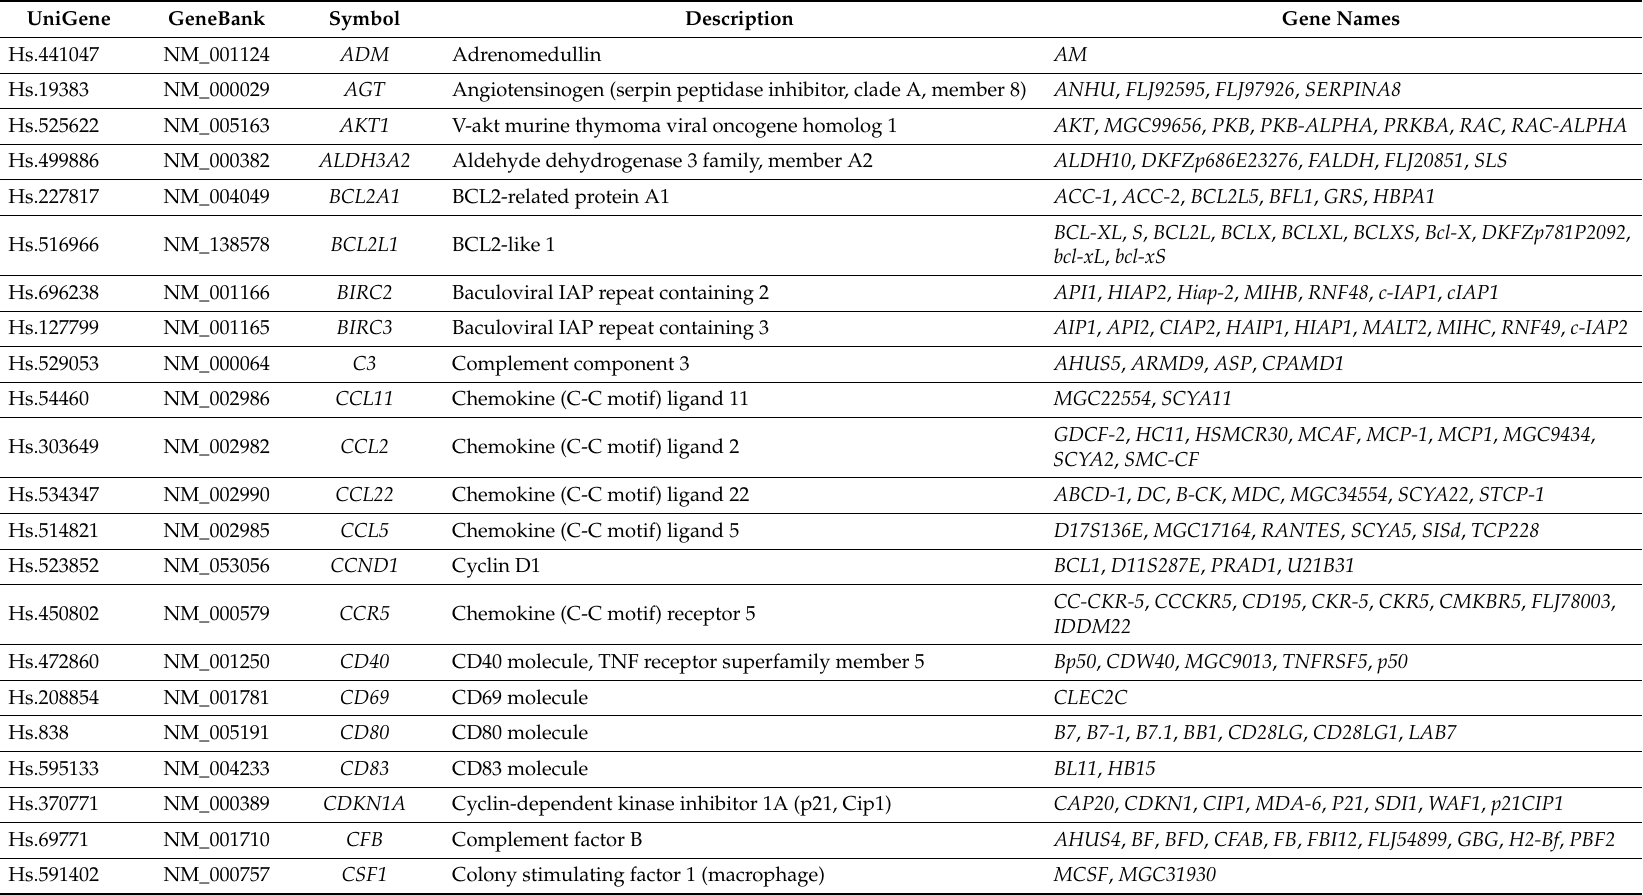
Table A1. Gene list of QPCR Array